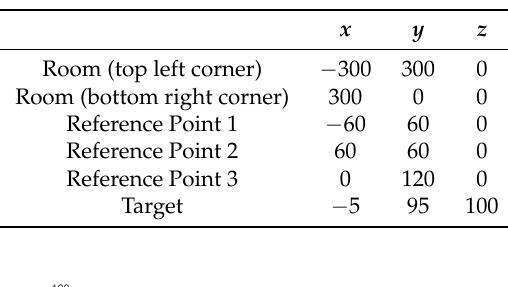
Table 1. Coordinates of the 3D rectangular room, and ideal positions of the reference points and target transducer (cm).